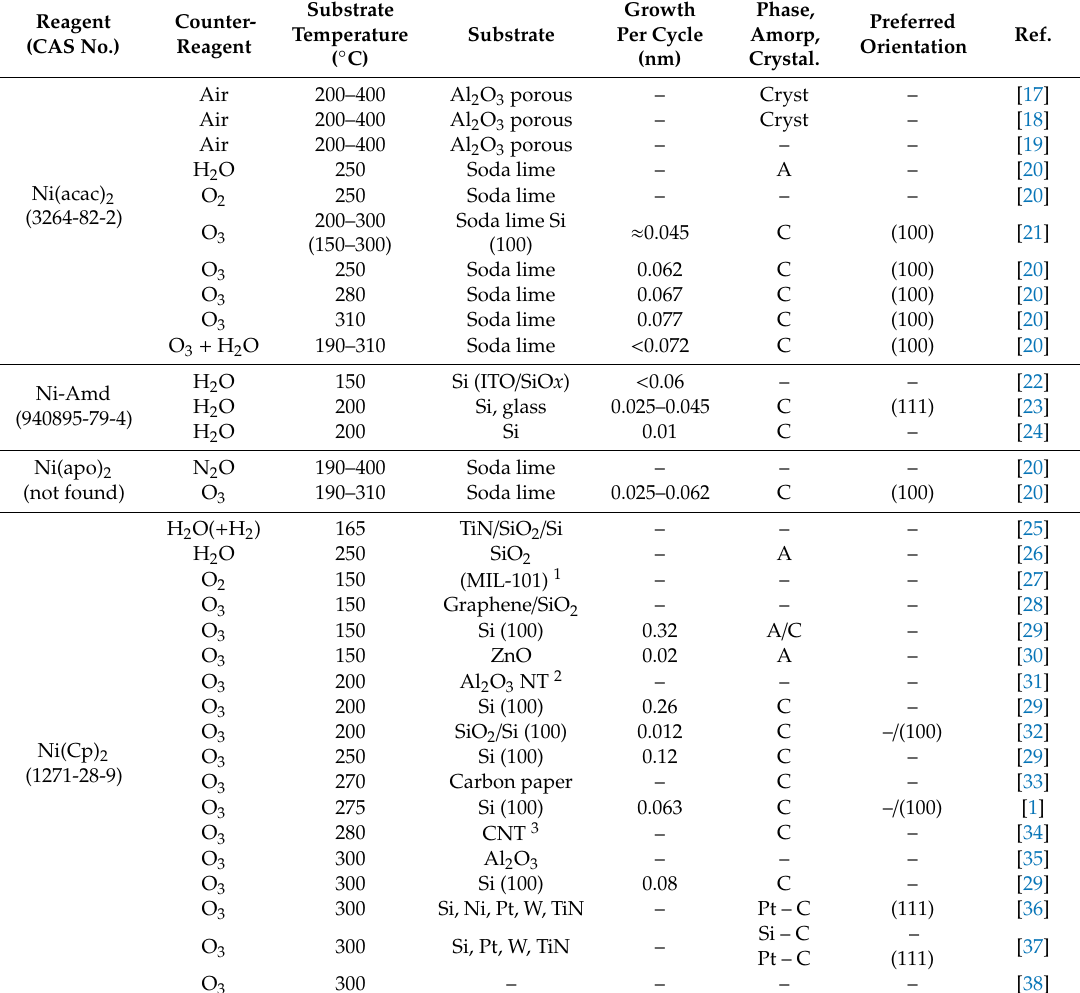
Table 1. Atomic layer deposition of NiO using di ff erent